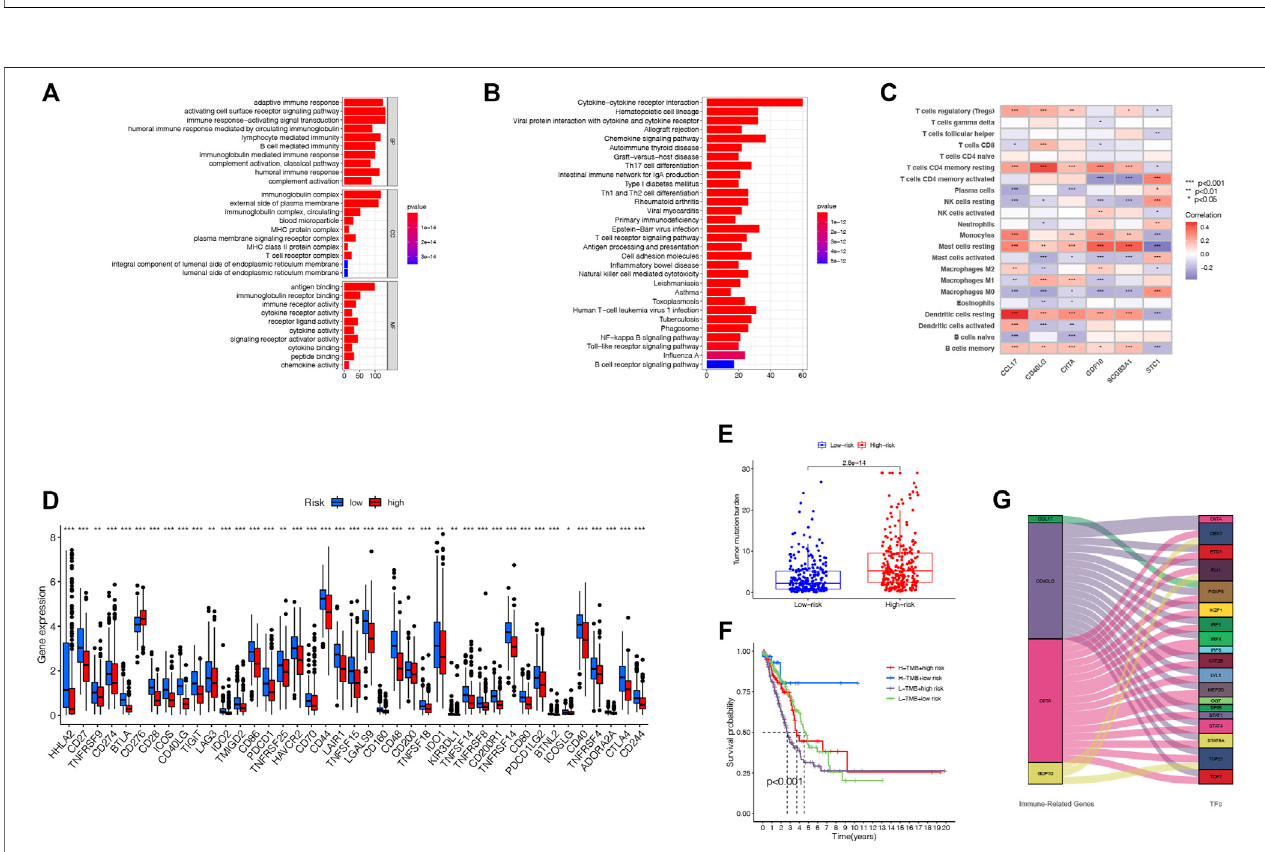
FIGURE 8 | Functional analysis and evaluation of immune activity between the two groups. (A) . GO analysis of TRIGs between various risk groups. (B) . KEGG analysis of TRIGs between various risk groups. (C) . Relationship between TRIG score and immune cell types. (D) . Expression of immune checkpoints in the high- and low-risk groups. (E) . Comparison of TMB between high- and low-risk groups. (F) . Comparison of four groups strati fi ed by combining the TMB and risk groups. (G) . Regulatory network of the TRIGs and TFs.